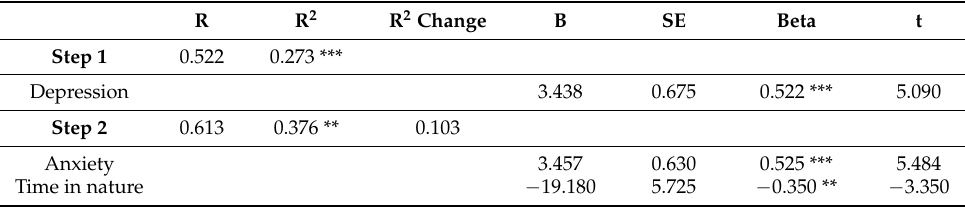
Table 6. Hierarchical multiple regression model of acute fatigue. Time in nature is a significant predictor of acute fatigue after controlling for